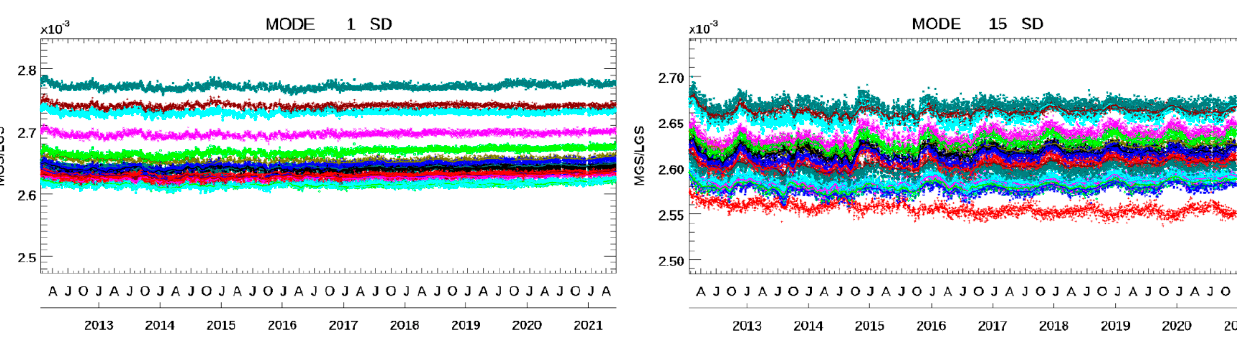
Figure 4. Ratio trend of DNB middle-to-low using SD dn signals at two aggregation modes (mode-1 and mode-15). Different colors are used to plot the DNB 16 detectors.